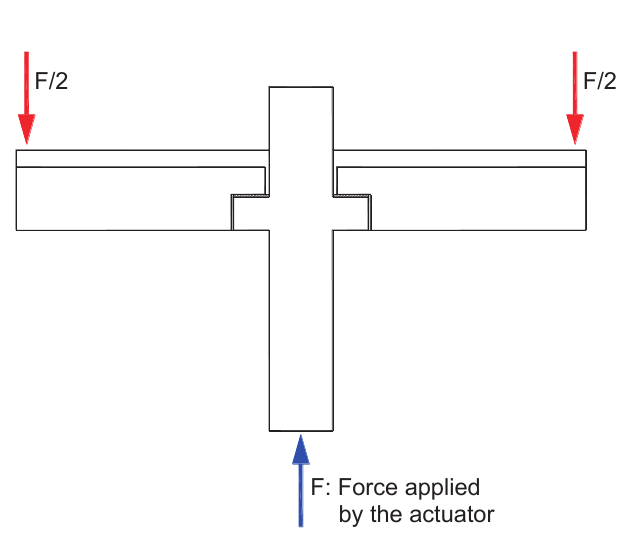
F: Force Figure 14 – Loading applied to the specimens Loading applied to the specimens